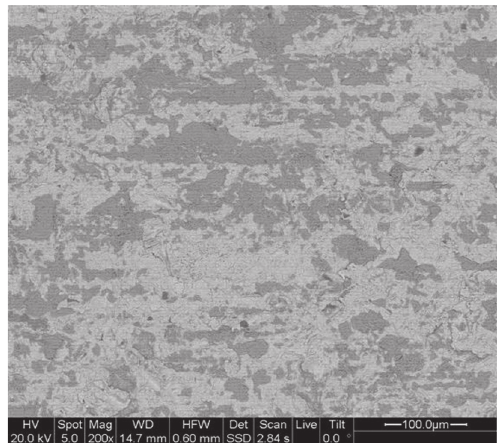
Figure 2: Surface image for the test